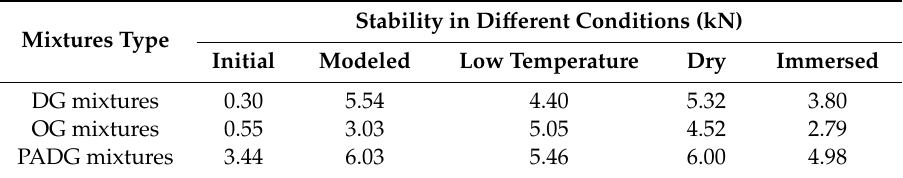
Table 3. Results of Marshall stability test in di ff erent conditions.